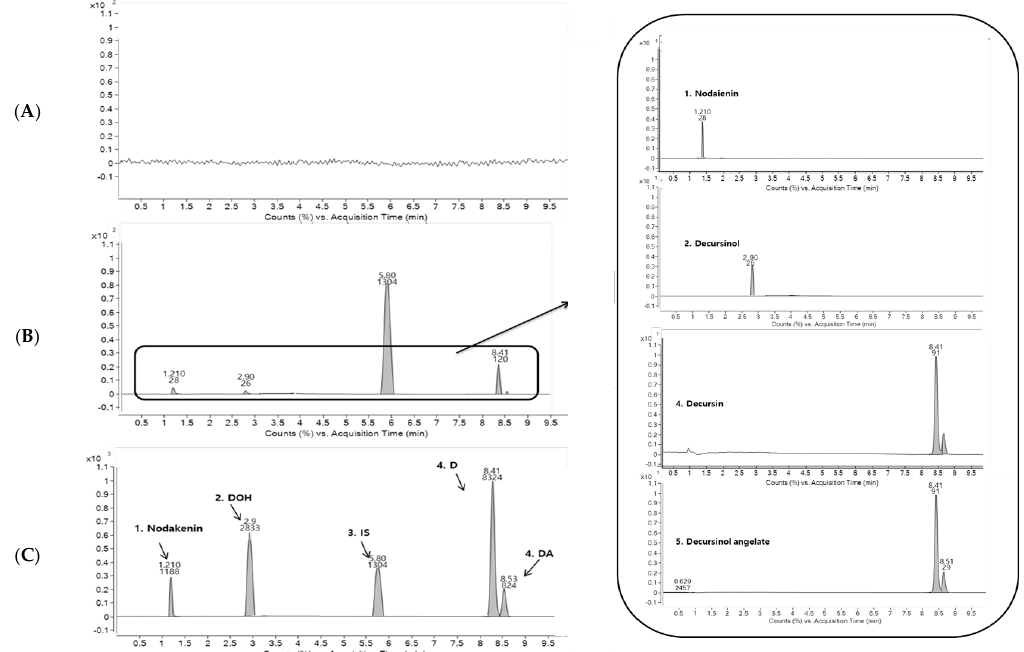
Figure 3. Representative MRM chromatograms of AGN root extract in human plasma samples (1, nodakenin; 2, decursinol; 3, IS; 4, decursin; and 5, decursinol angelate). ( A ) blank human plasma, ( B ) human plasma spiked with the four coumarins at LLOQ of 0.05 ng/mL and IS (10 ng/mL), ( C ) human plasma taken at 1 h after the usual oral dose administration of 4.6 g of AGN root extract powder containing 0.055 mg of D, 0.184 mg of DA, and 1.095 mg of nodakenin.